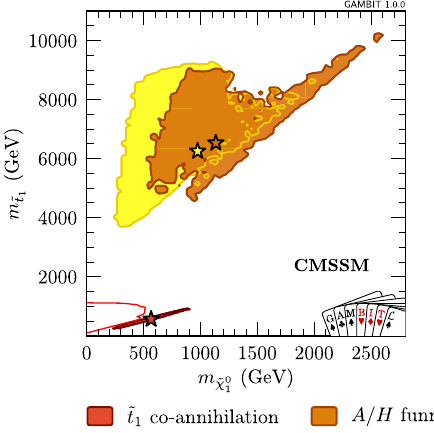
Fig. 15 95% CL 2D profile likelihoods in the ˜ t 1 − ˜ χ 0 coloured according to the mechanism(s) active in depleting the relic density. Left: the CMSSM. Right: the NUHM1. Superimposed in red